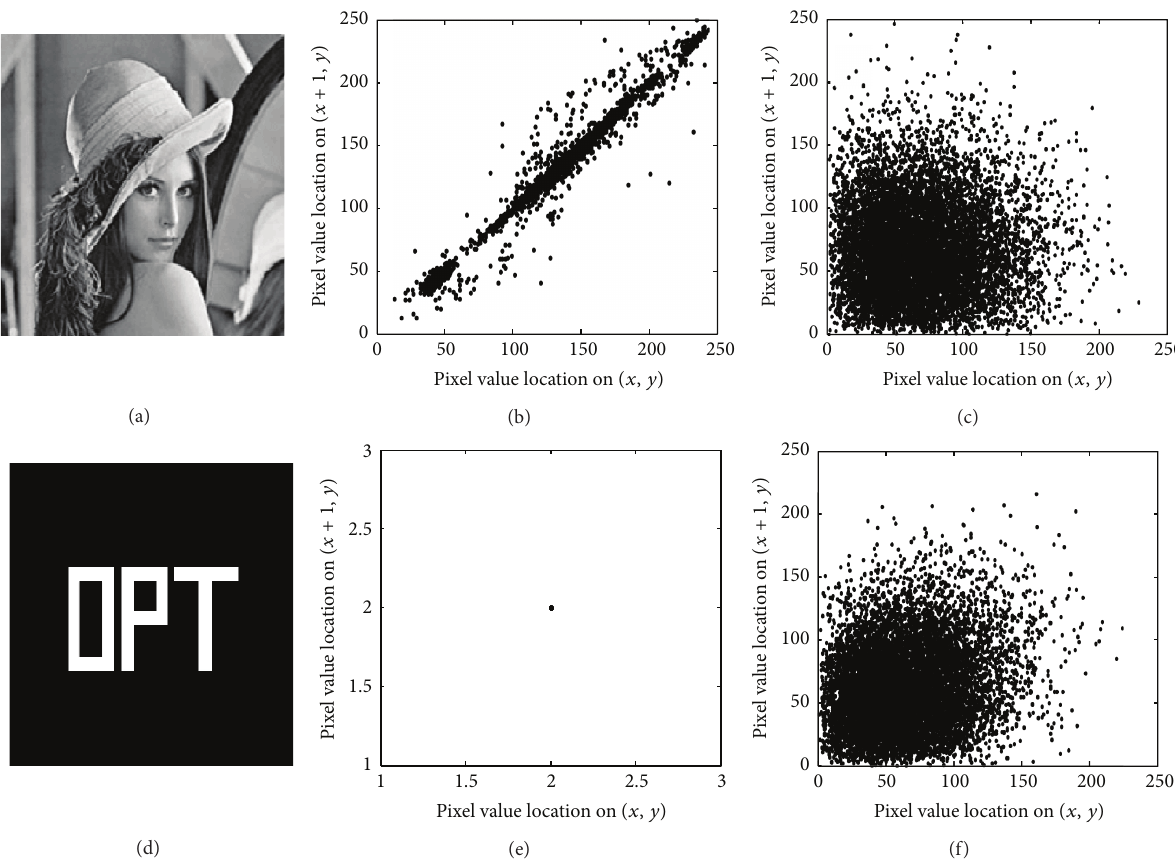
Figure 4: Plots of correlation distribution for randomly chosen 10,000 pixel pairs: (a) input image Lena; (b, c) correlation distribution respectively of input and encrypted image of Lena; (d) input image OPT; (e, f) correlation distribution, respectively, of input and encrypted image of